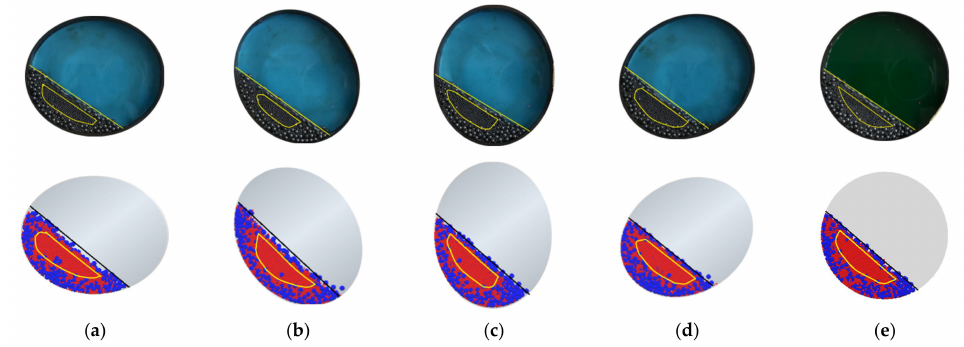
Figure 3. Comparison diagram of experimental and simulated operating conditions of the rotary drum. ( a ) 0 ◦ ; ( b ) 60 ◦ ; ( c ) 90 ◦ ; ( d ) 150 ◦ ; ( e )